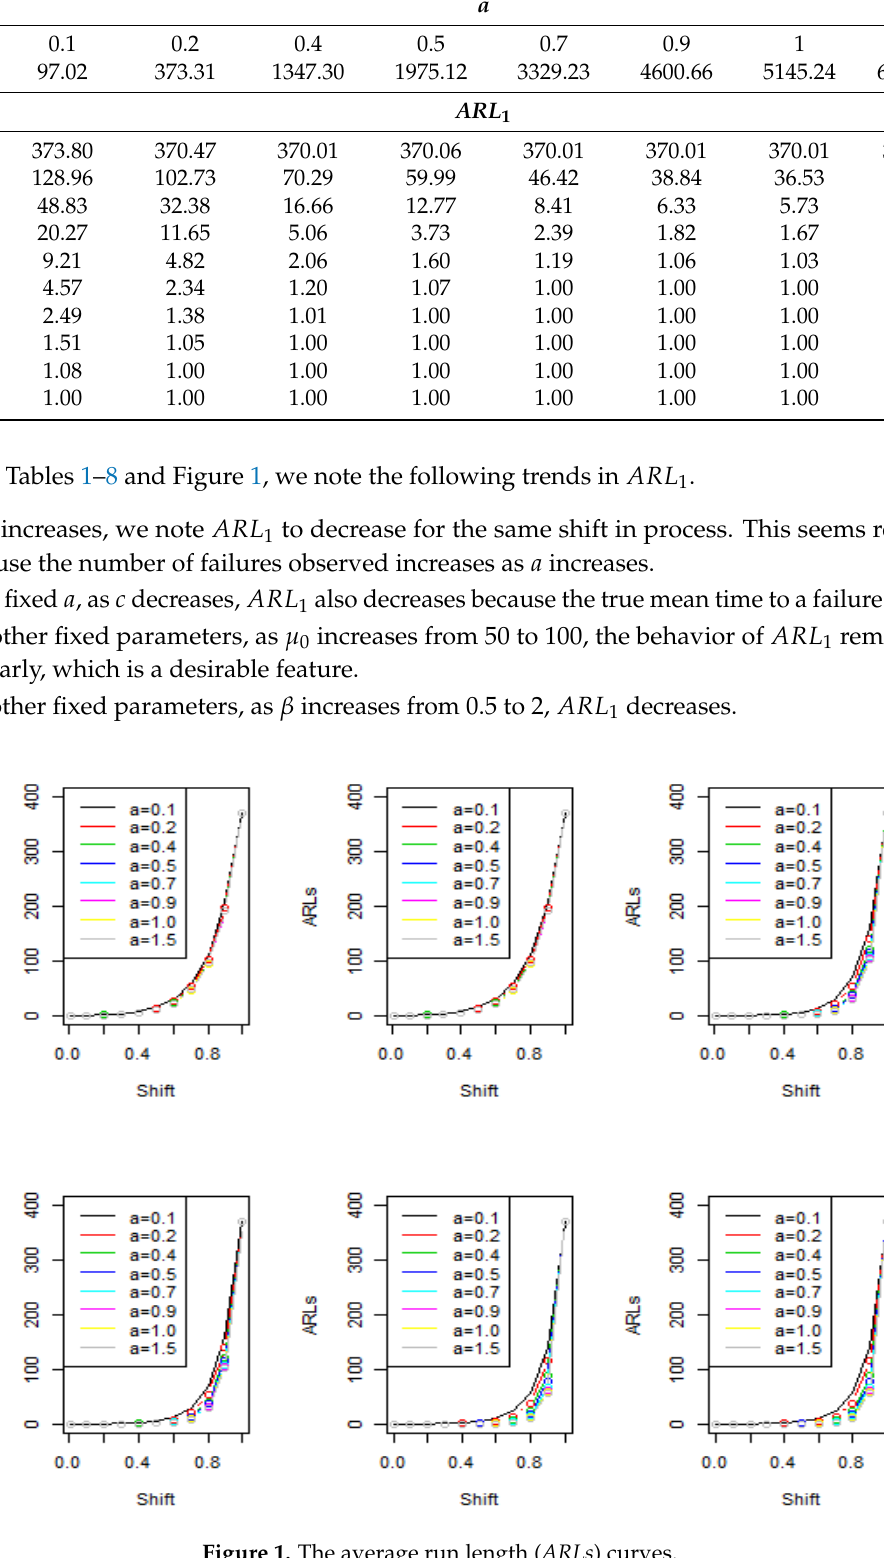
Figure 1. The average run length ( ARLs ) curves.